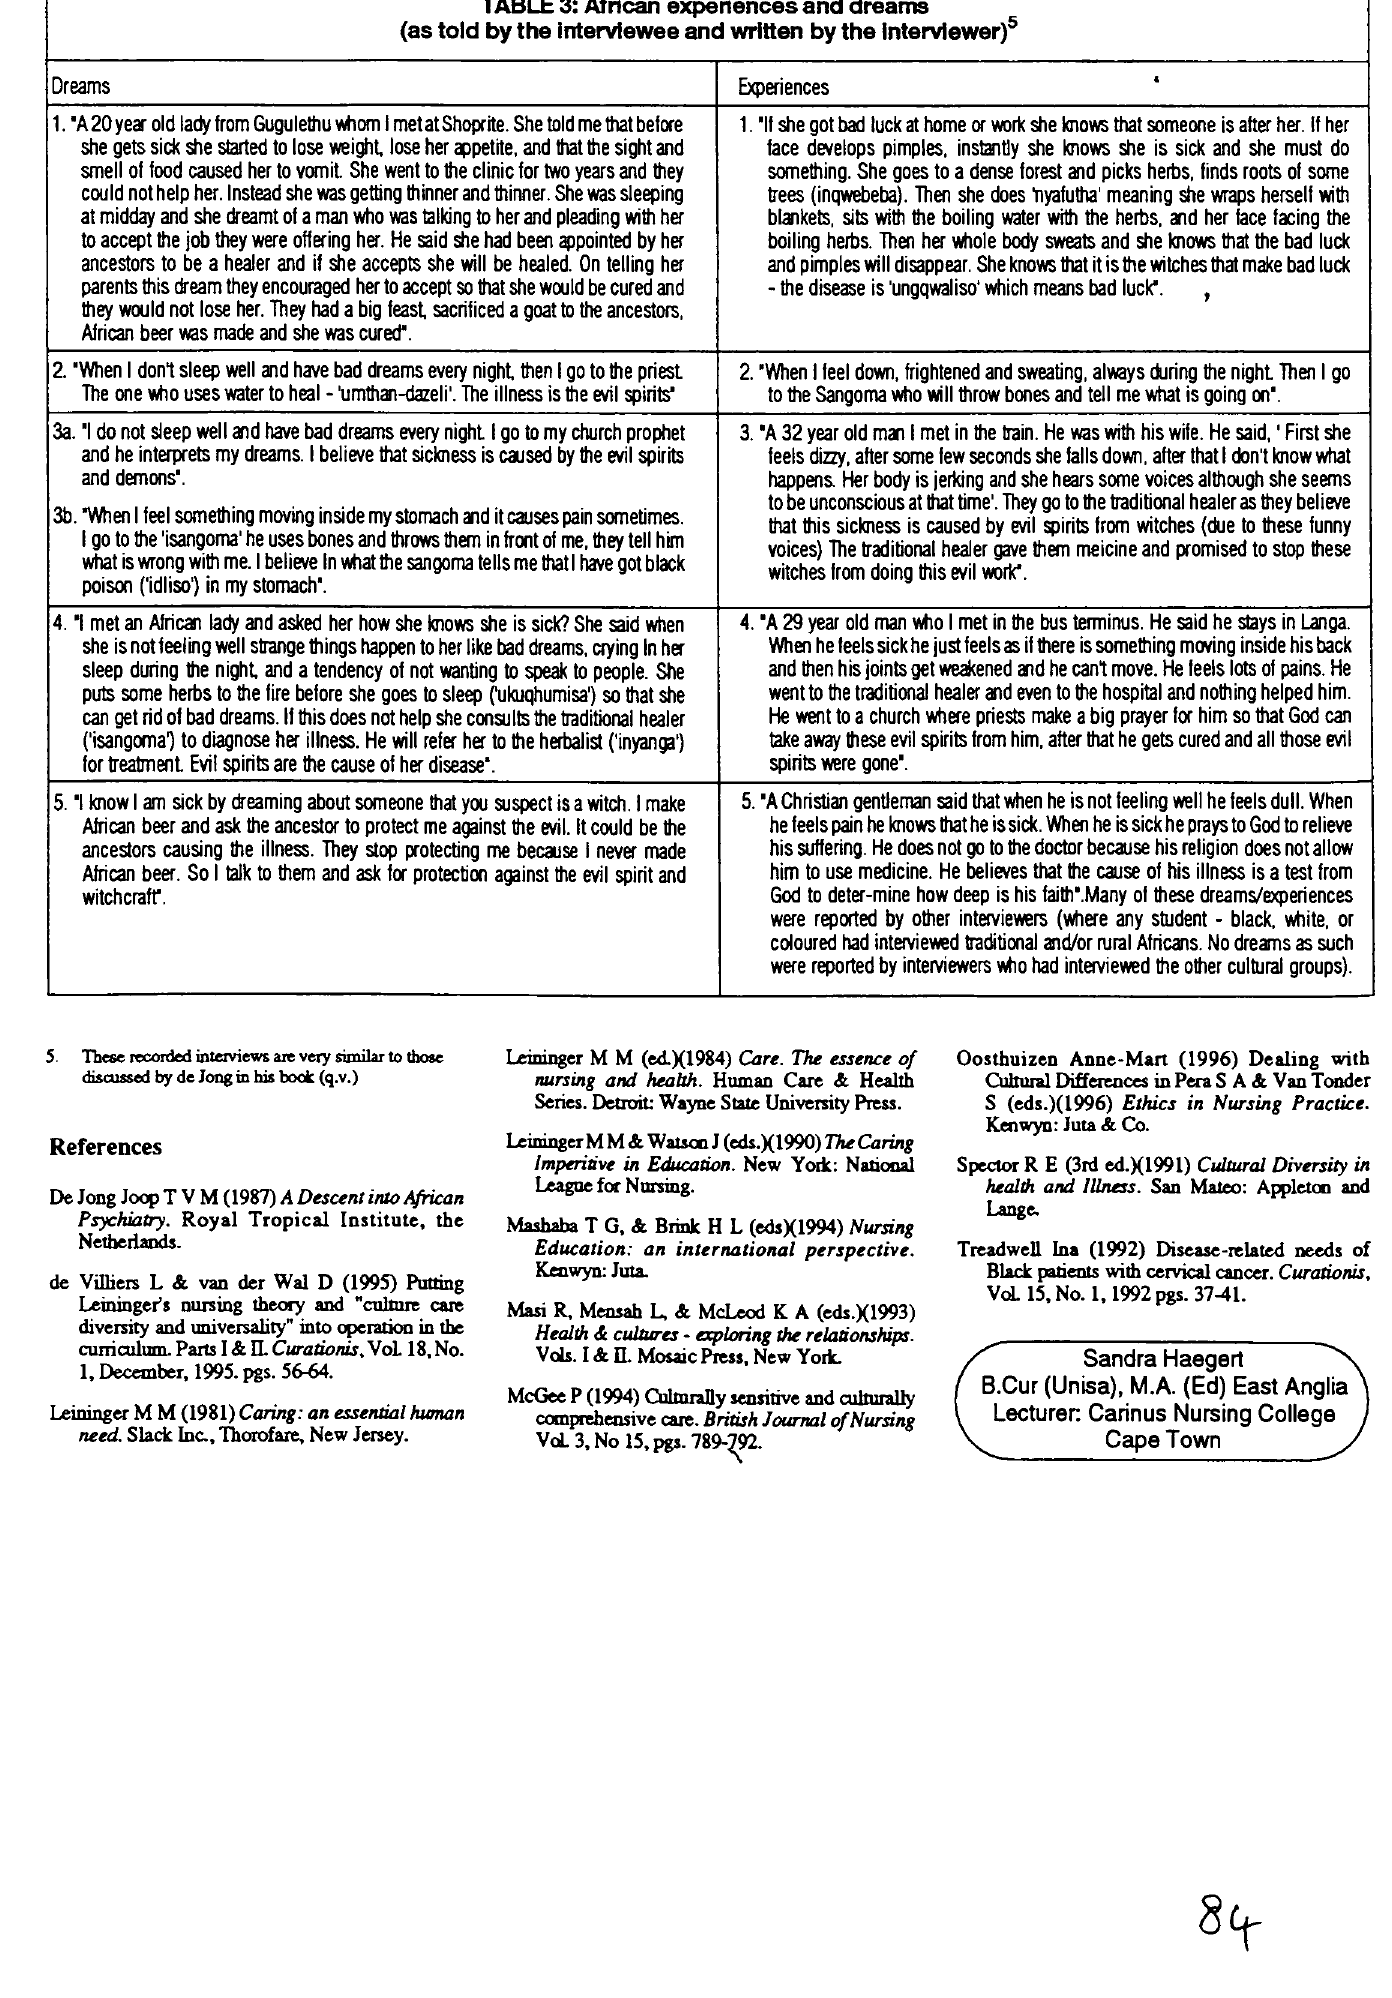
TABLE 3: African experiences and